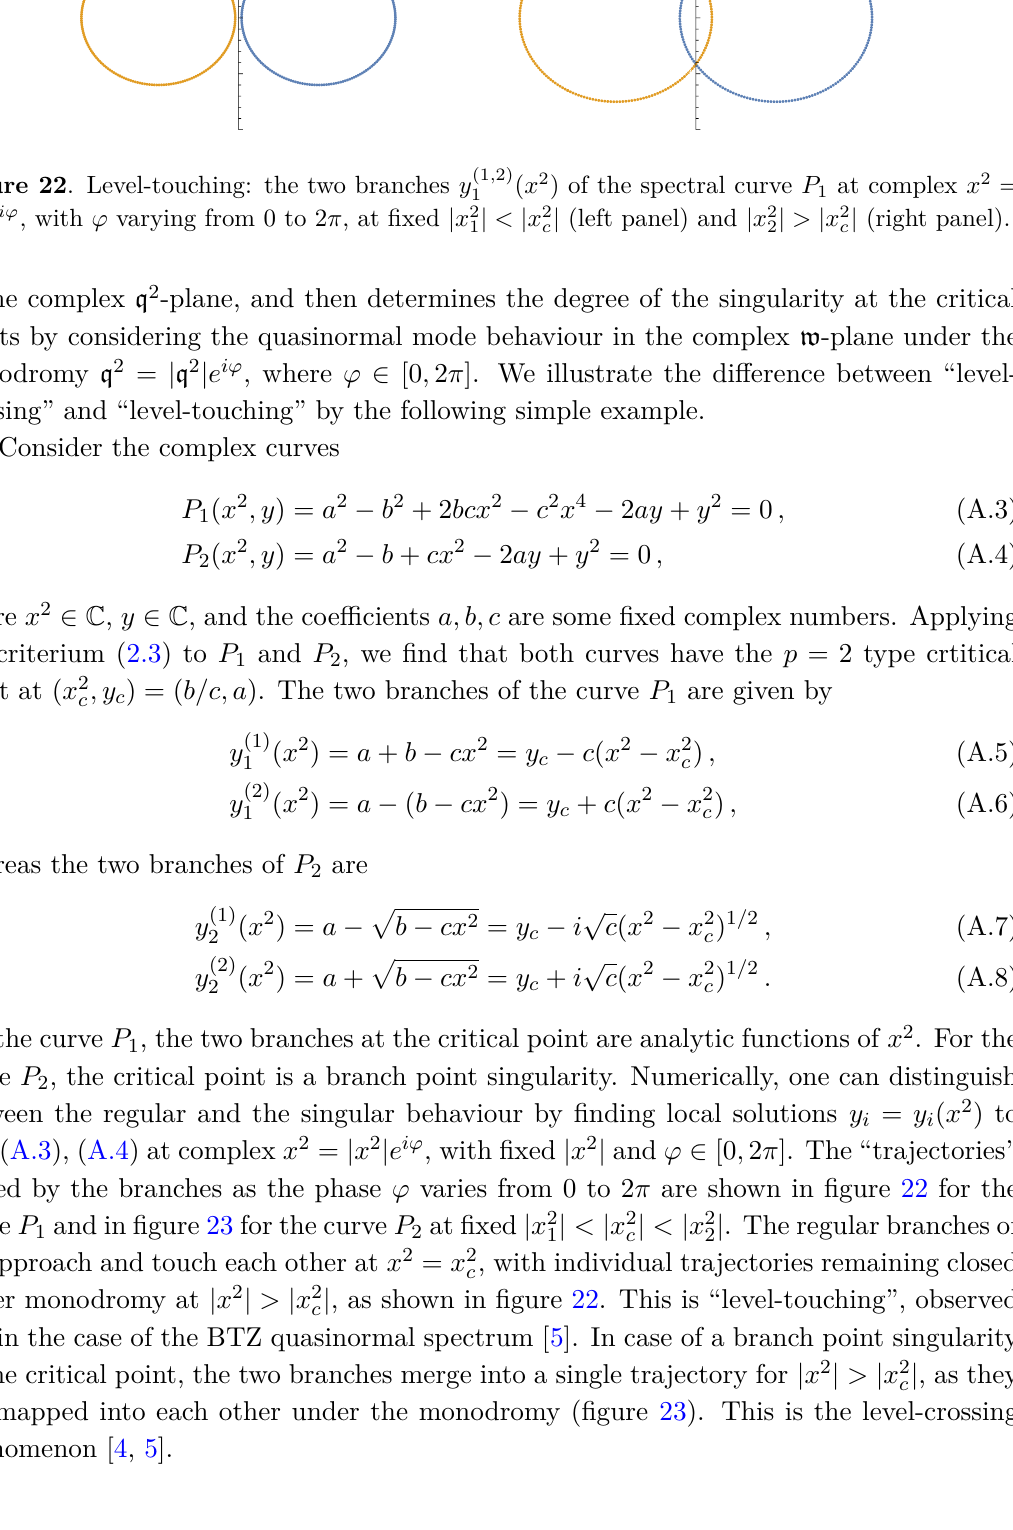
| > | x 2 | (right panel). c 2